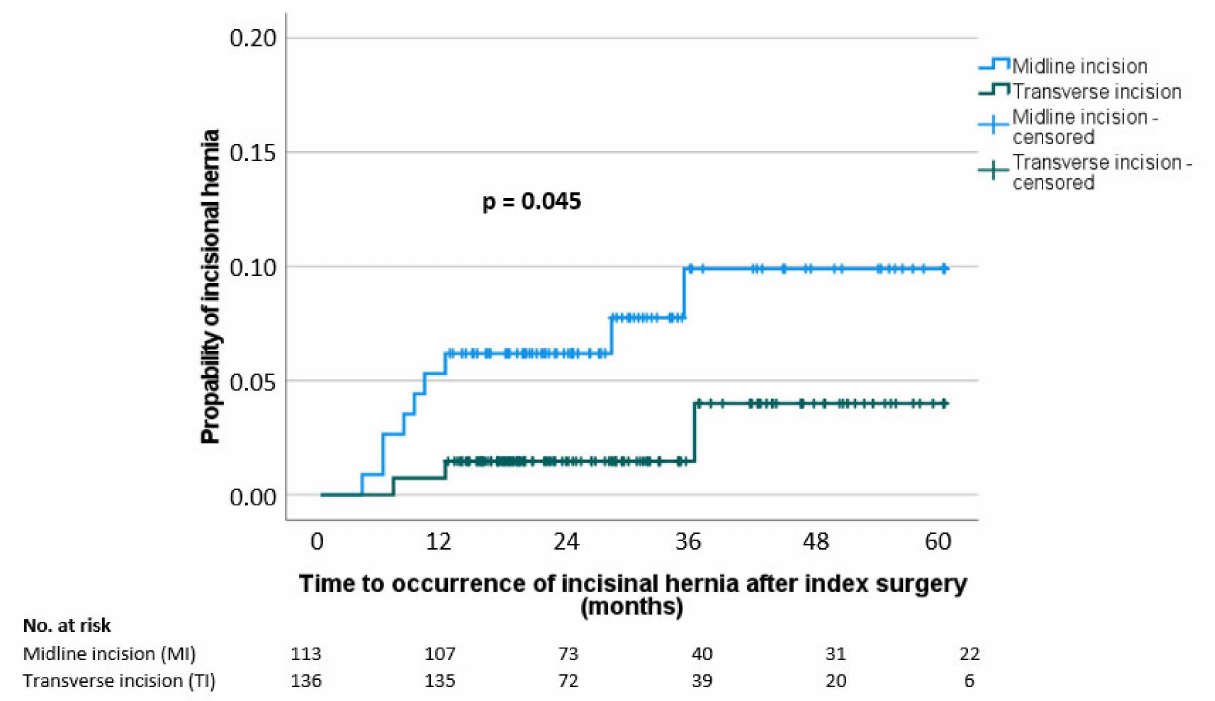
Figure 1. Probability of incisional hernia stratified by incision type (midline incision (MI) and transverse incision (TI)) ( n =